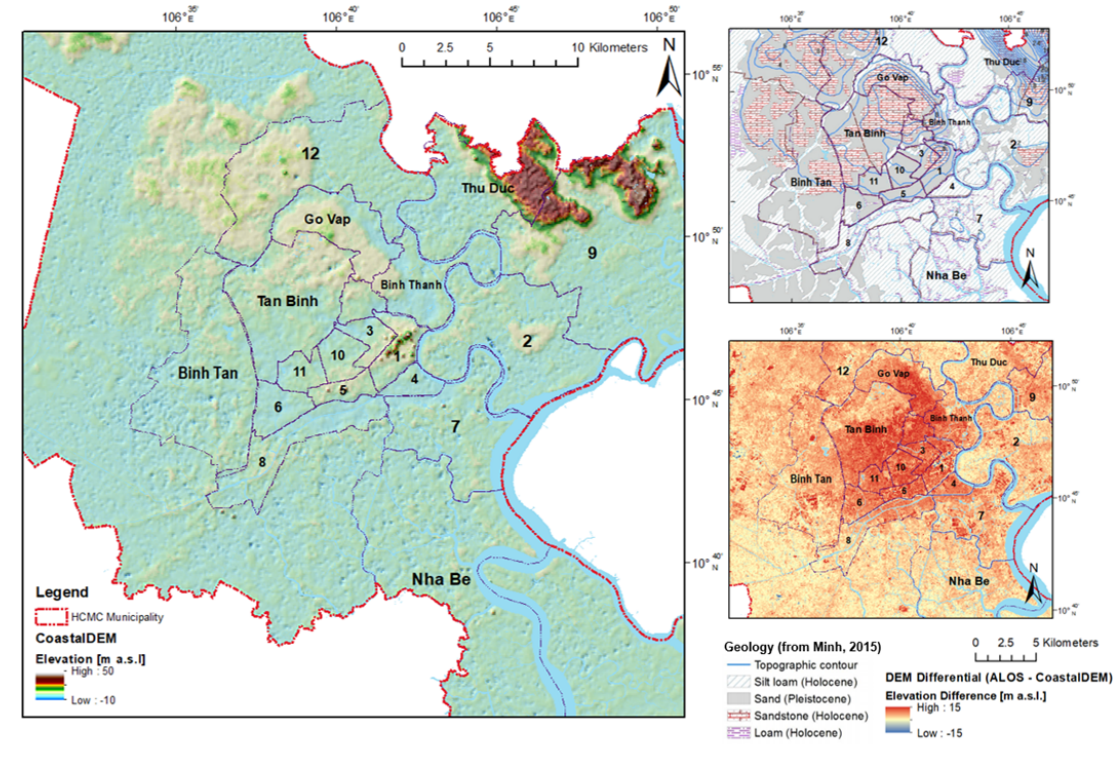
Figure 7. Coastal-Digital Elevation Model (DEM) of HCMC ( left ), the geology and topographic contour of ALOS data used in Minh 2015 ( top right) and the elevation difference between the ALOS DEM and Coastal-DEM ( bottom right